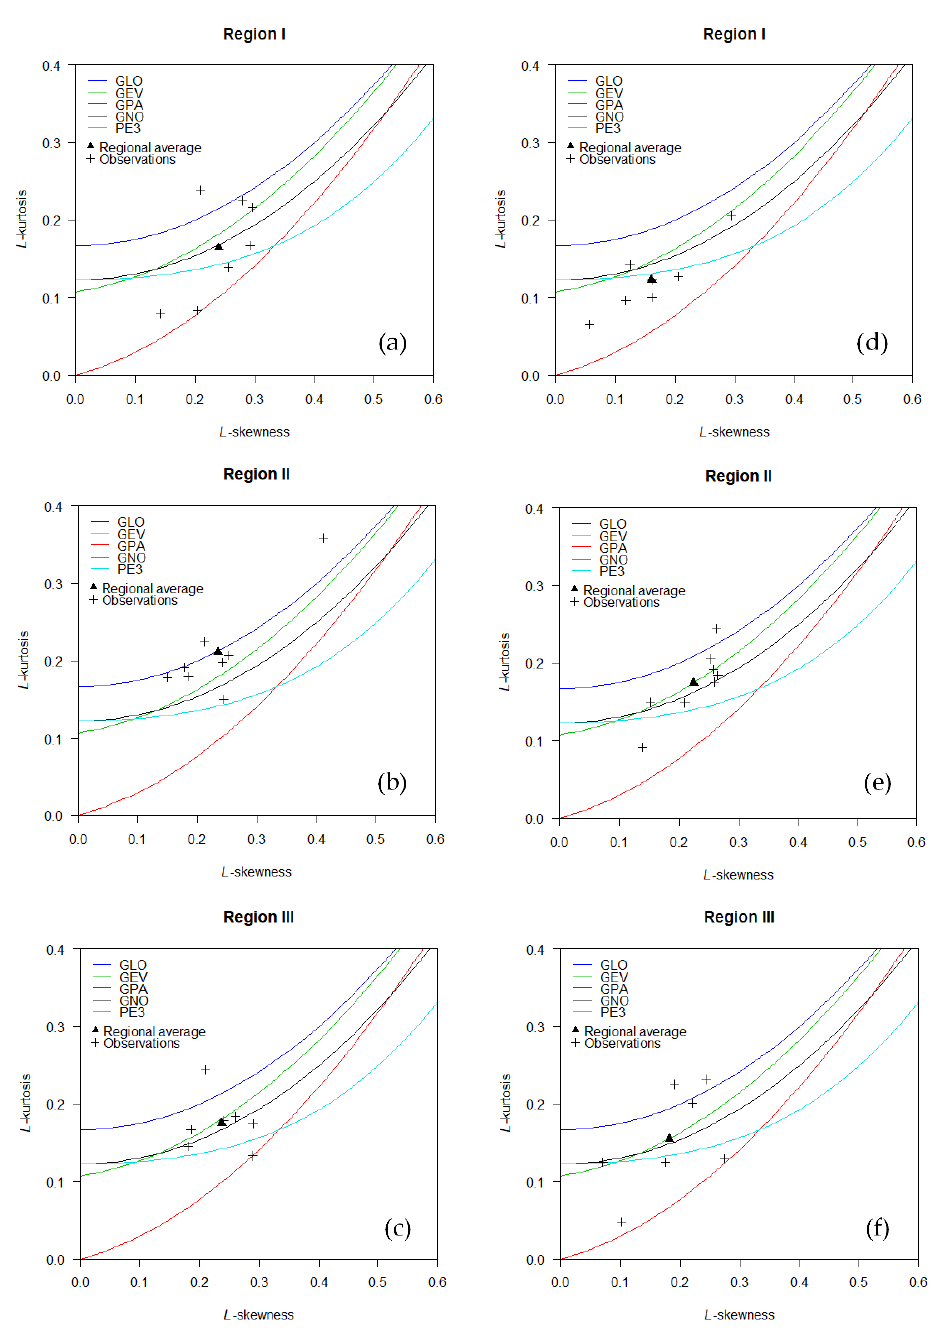
Figure 3. L-moment ratio plot for RX1day ( a , b , c ) and RX5day ( d , e , f ) series at three HOM regions.